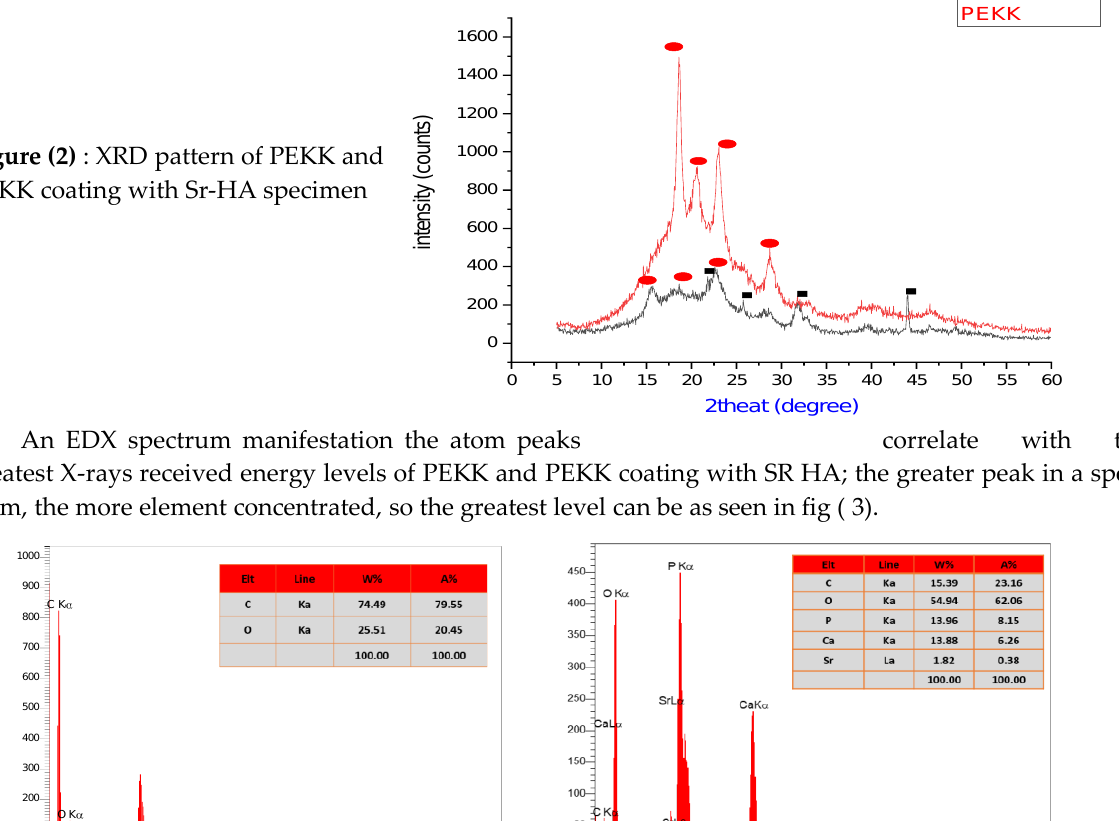
Figure (2) : XRD pattern of PEKK and PEKK coating with Sr-HA specimen